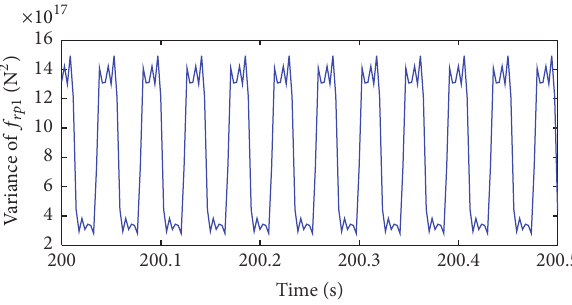
Figure 8: Variances of 𝑓 𝑟𝑝1 , meshing force at 1st 𝑟 − 𝑝